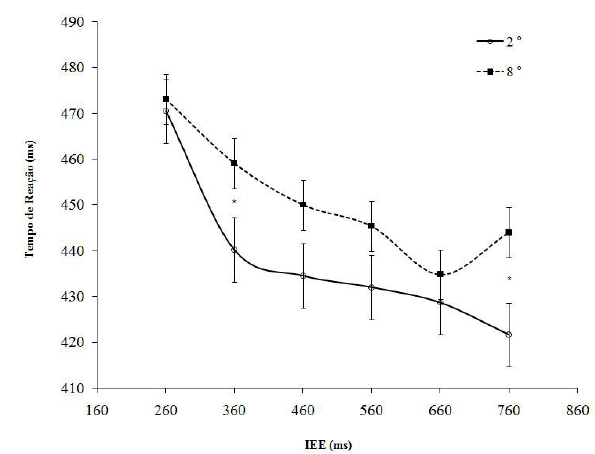
Figura 2. Tempo de reação médio (TR) em função do tamanho da dica visual (2 ou 8 graus de ângulo visual) e do intervalo entre estímulos (IEE). O asterisco indica as diferenças